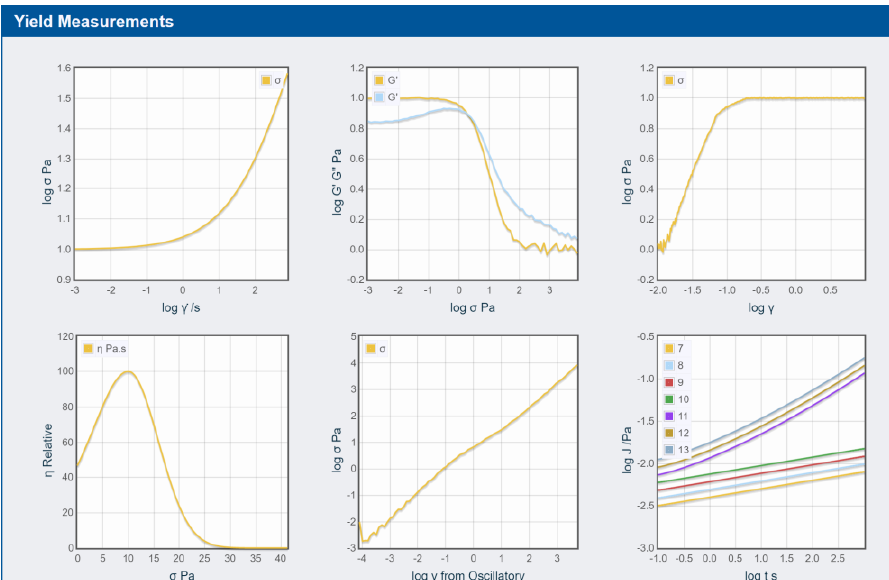
Figure 8. Yield stress is important in many aspects of printing. However, which method should be used to measure it? These six plots show the same yield stress being measured in six different ways. Arguably the top-left and top-middle are the most common, though the others are relatively common. The app is at www.stevenabbott.co.uk/practical-rheology/Yield-Measurement.php.